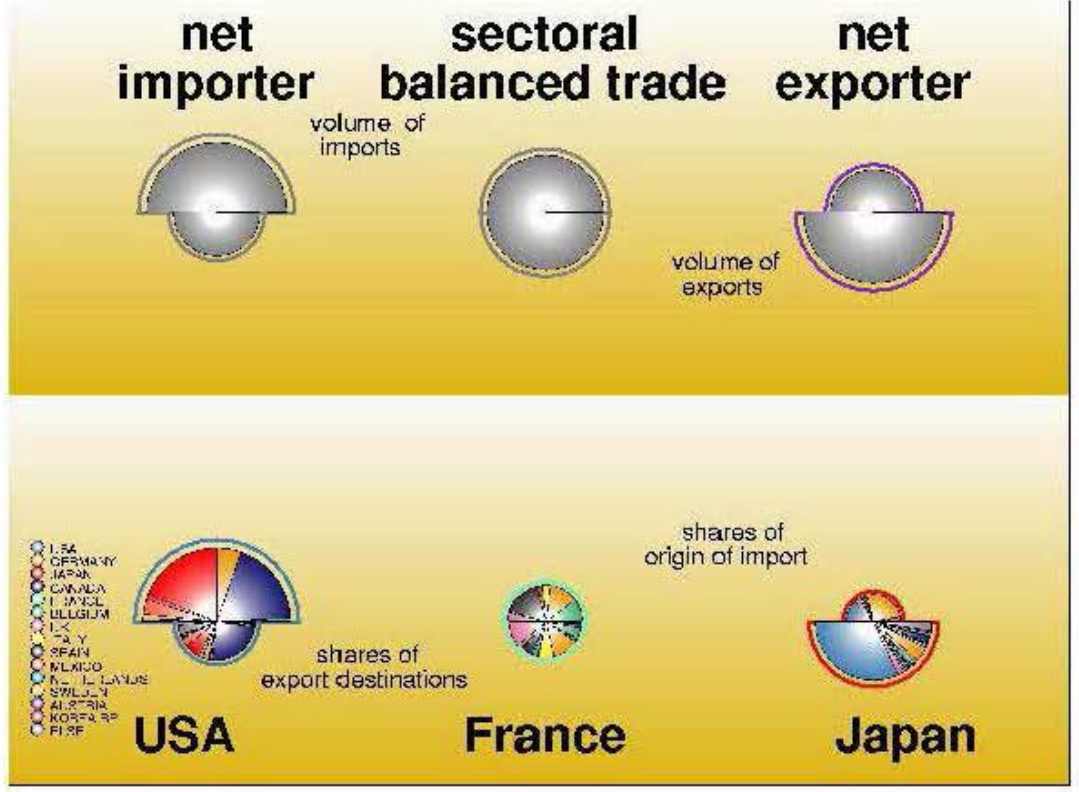
Figure I.: S}mbol$ U$ed to SummarizJ! tl1e Sectoral Balance of National